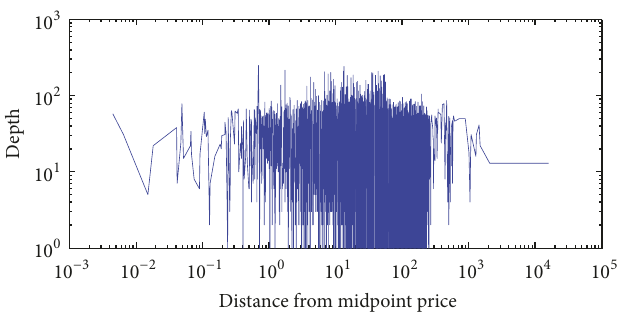
Figure 15: Log-log scale of market depth.